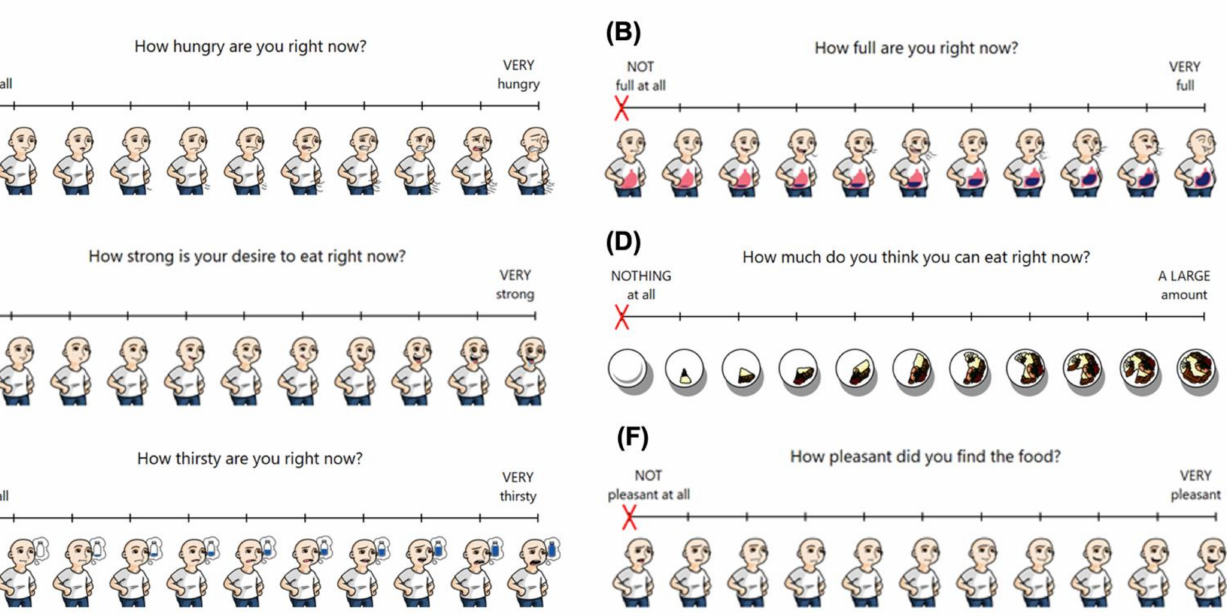
Figure 1. VAS images schematics: ( A ) Hunger, ( B ) Fullness, ( C ) Desire To Eat (DTE), ( D ) Prospective Food Consumption (PFC), ( E ) Thirst, and ( F )